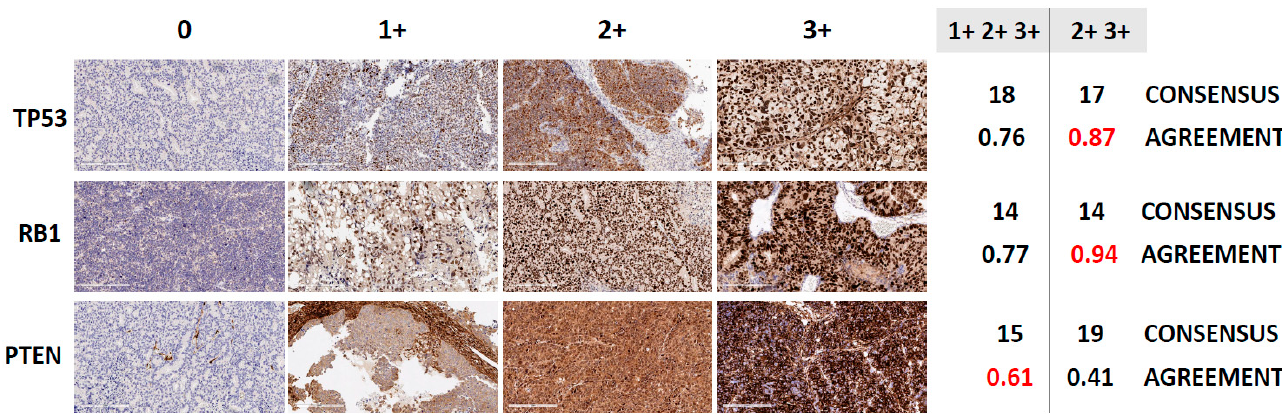
Figure 2. Consensus and agreement calling in immunohistochemistry (IHC)-based determination of tumor suppressor loss, in 28 PDX models of human prostate cancer. Figure 2 shows representative photomicrographs of PDXs stained for TP53, RB1 and PTEN demonstrating different staining intensity levels, and the proportion of samples a reviewer votes with the consensus vote for different markers (TP53, RB1 and PTEN) and definitions of positive (1+2+3+ or 2+3+ IHC % labeling indices). The consensus vote is the majority determination of abnormal for that sample across the 9 reviews (3 labs × 3 reviewers). Shown are the number of abnormal samples based on the consensus of the reviews and the Fleiss κ , which measures the level of agreement among the reviewers. Fleiss κ values of 0.41–0.60 indicate moderate agreement, 0.61–0.80 substantial agreement, and 0.81–1.00 almost perfect agreement. Also shown are representative IHC images reflecting 0, 1+, 2+ and 3+ staining intensities for TP53, RB1 and PTEN (magnification: 20×, scale bar = 200 µm).